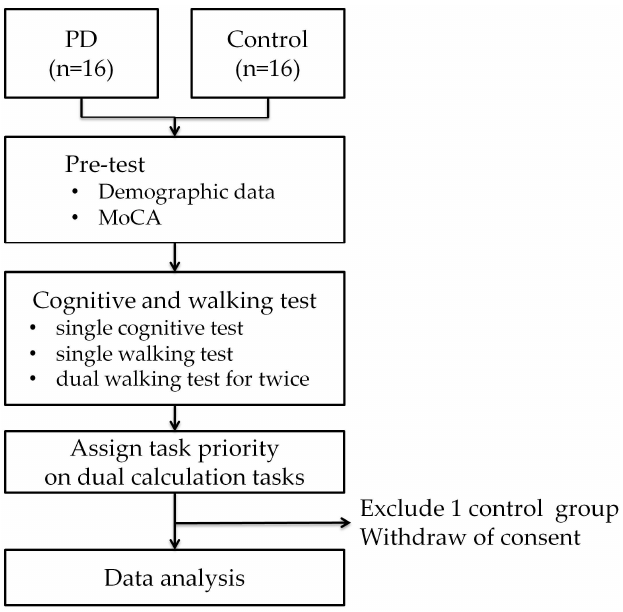
Figure 2. Figure 2. Flowchart.